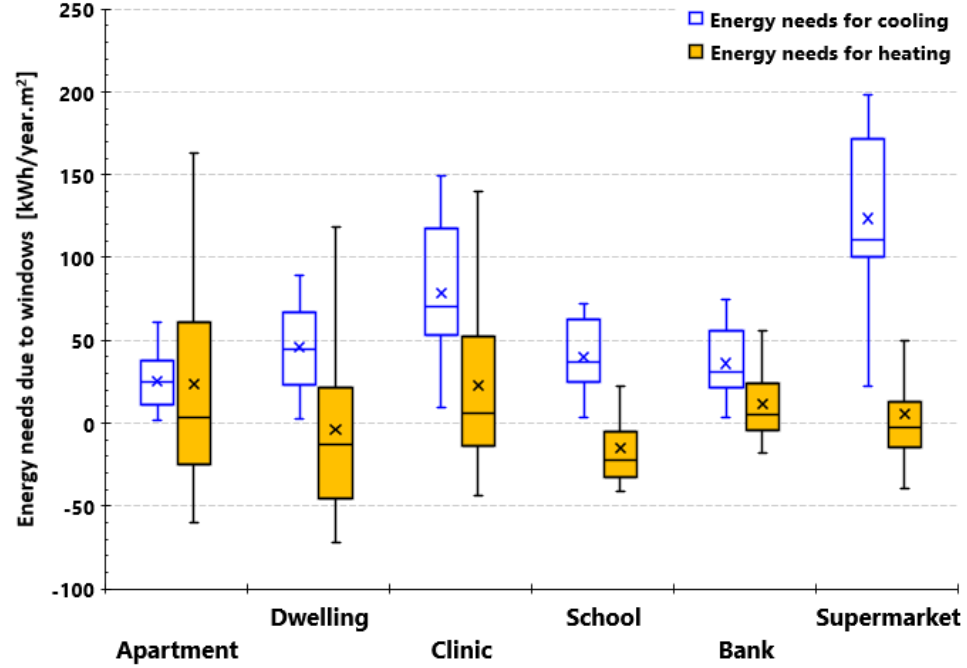
Figure 2. Energy needs for heating and for cooling due to windows (values per m 2 of glazed area of external envelope). Values for each building include all climate zones and all windows type.